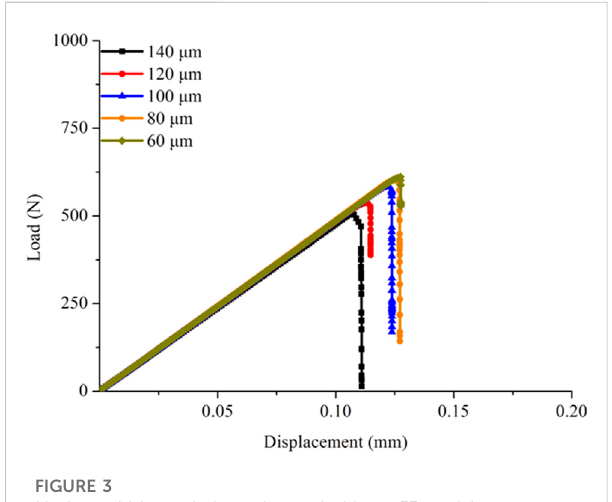
Mesh sensitivity analysis on the cortical bone FE models.